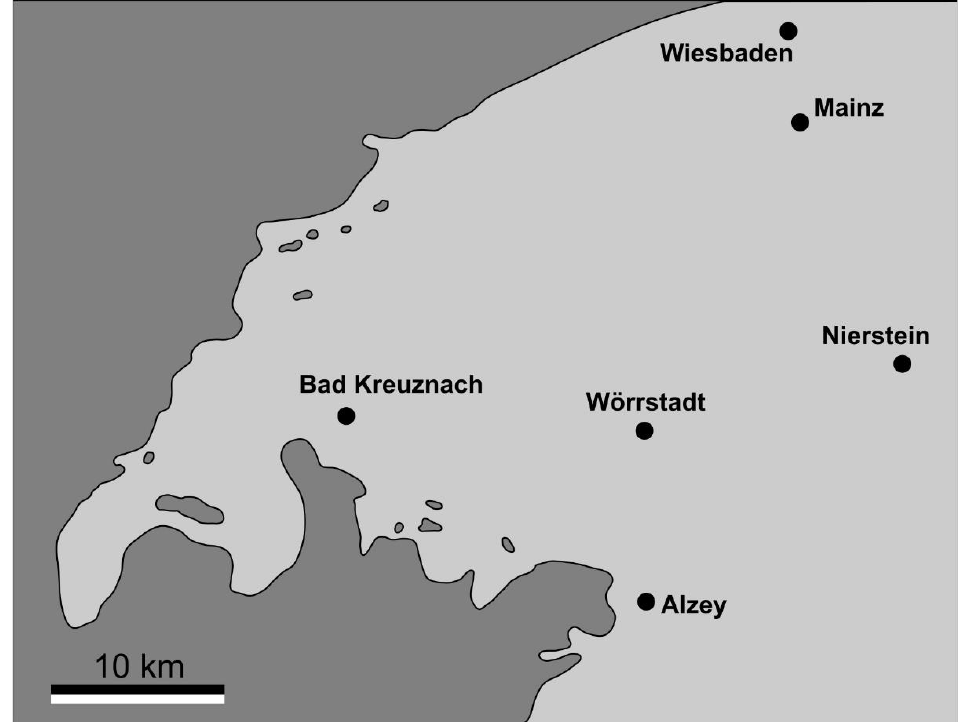
Figure 2. Palaeogeography of the northern Mainz Basin at the time of deposition of the Rosenberg Subformation, with emerged land in dark grey and areas covered by sea in light grey, modified from Schäfer [13].